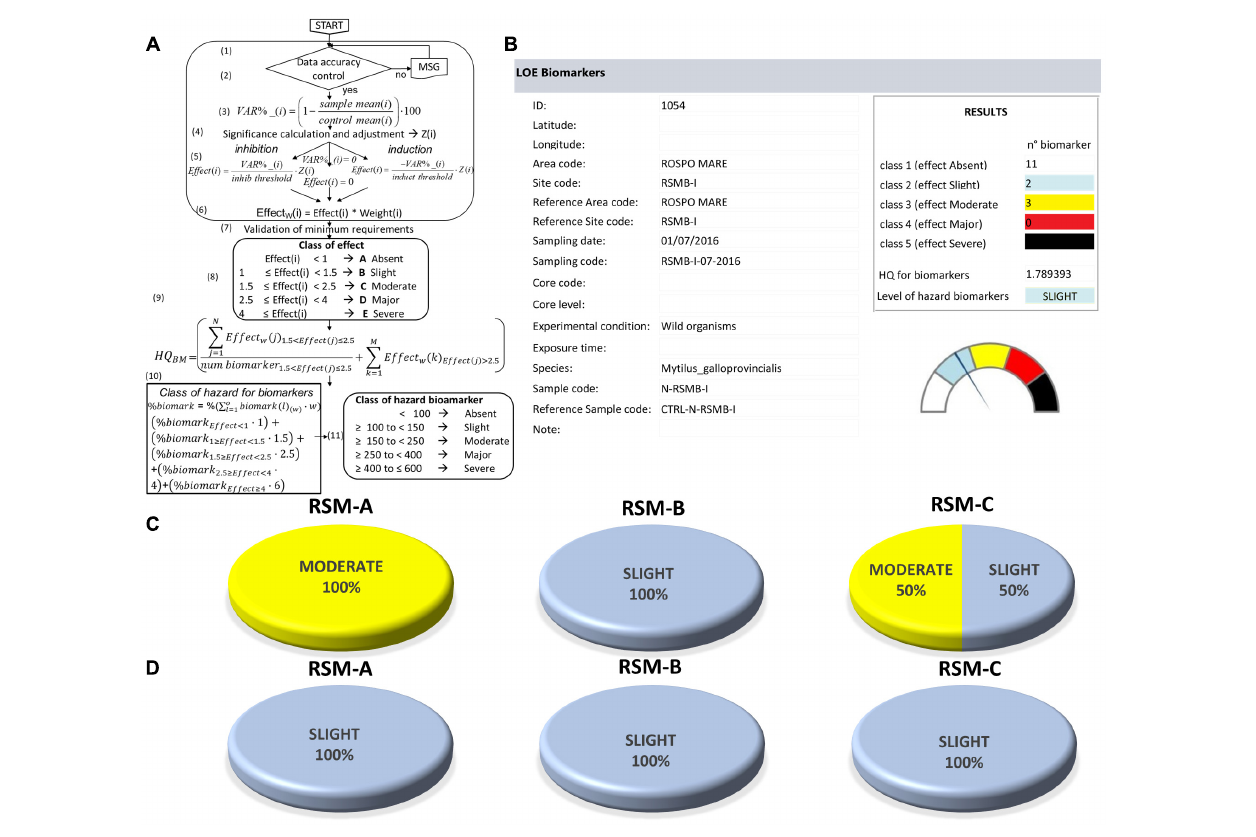
FIGURE 4 | LOE-3: elaboration of biomarker results. (A) Flowchart and calculations of Biomarkers Hazard Quotient (HQ BM ). (B) Model output of biomarker characterization. (C,D) Results obtained for the three platforms indicating the percentage distribution of samples assigned to various classes of hazard for native (C) and transplanted mussels (D)